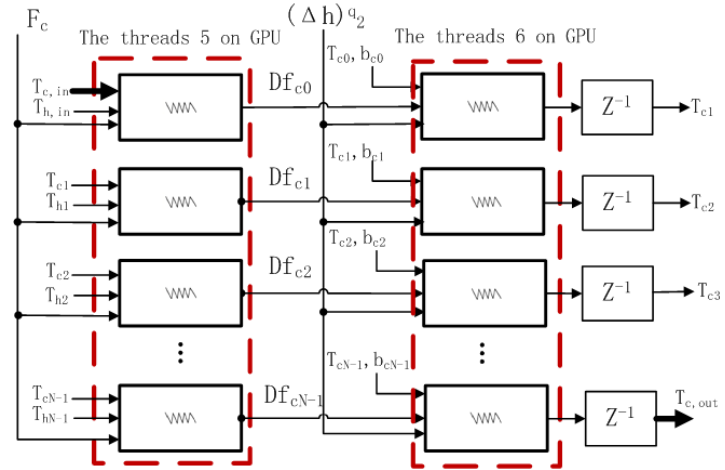
Figure 7. The thread blocks of the proposed parallel model in cold fluid for the parallel-flow heat